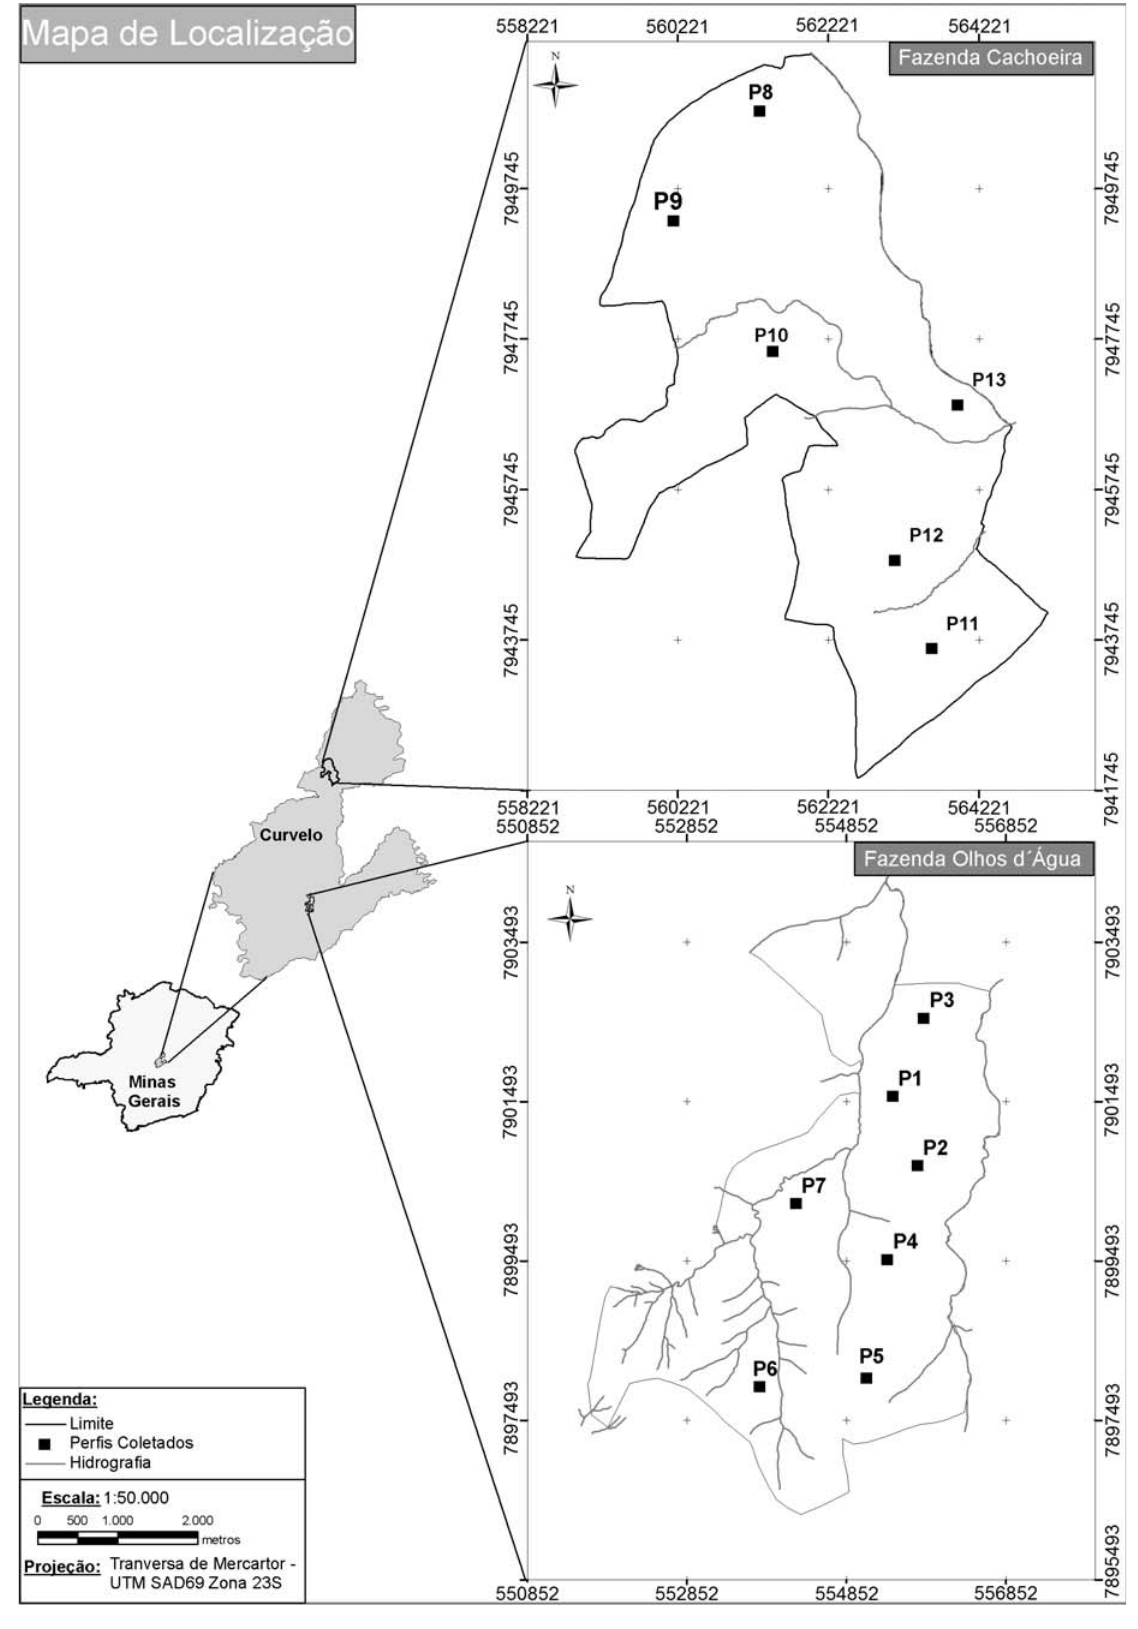
Figura 1. Localização das áreas trabalhadas e dos perfis